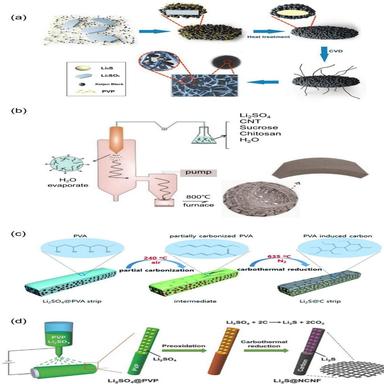
The schematic of (a) Li2S/KB@Cf using PVP and KB as carbon precursors. (b) Li2S-C-N-O@CNT using CNT, sucrose & chitosan as carbon precursors . (c) Li2S@C-CNT using PVA and CNT as carbon precursors . (d) Li2S@NCNF using PVP as carbon precursor. Reproduced from Refs. with permission from Elsevier, Royal Society of Chemistry, and Wiley.